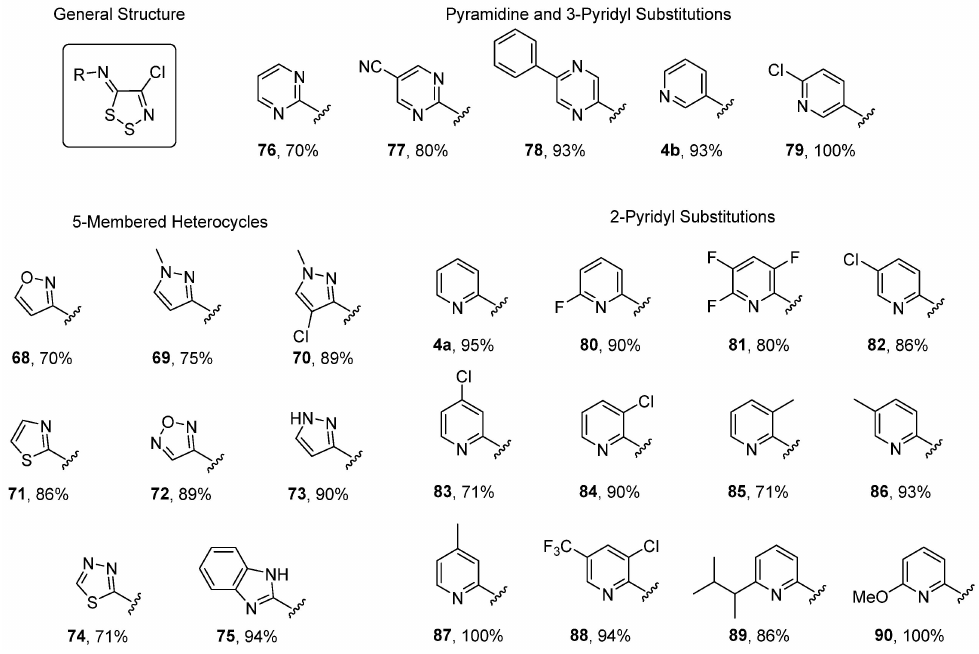
Figure 12. Phytophtora (tomato) preventive; ≥ 70% efficacy at concentration of 1500